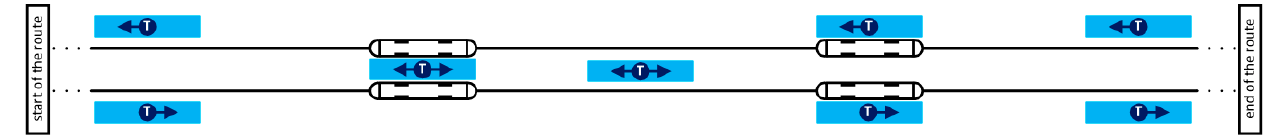
Figure 12. Using the bi-directional tram to serve tram stops located on island platforms.